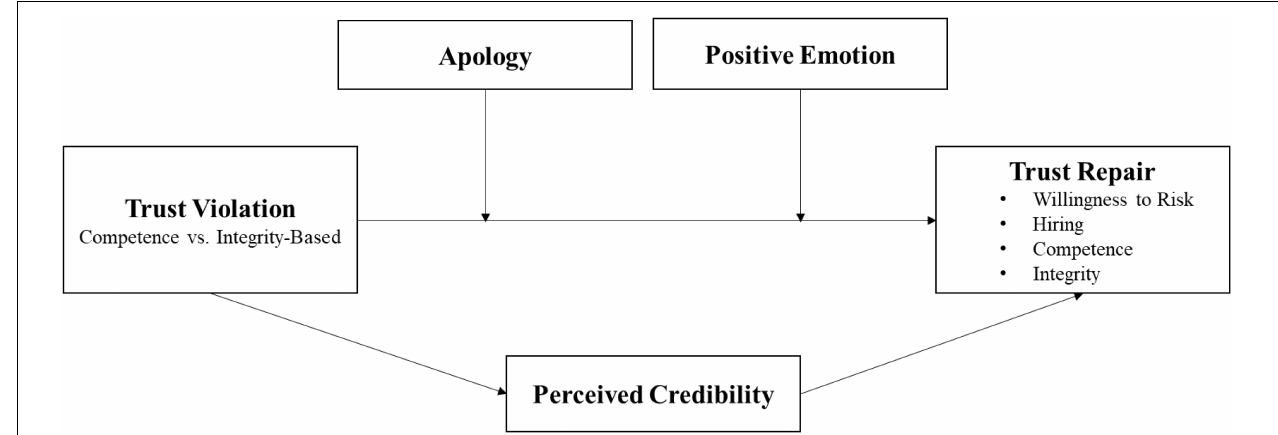
FIGURE 1 | Proposed research